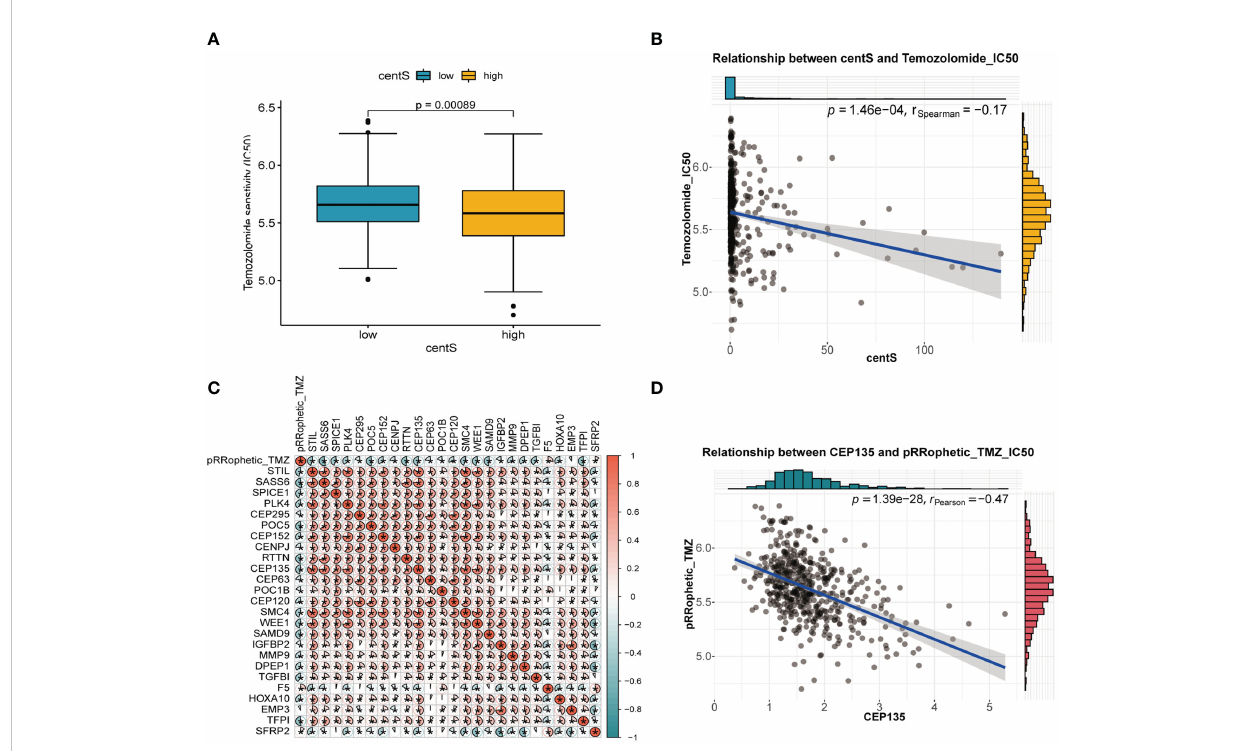
FIGURE 10 Temozolomide sensitivity analysis of centS and CRGs in LGG. (A) difference analysis of IC50 value of Temozolomide in high- and low- centS group performed by “ pRRophetic ” package. (B) Correlation analysis of centS and IC50 value of Temozolomide. (C) The correlation matrix to show the relationship of the IC50 value of Temozolomide with 13 CRGs and 12 signature genes. Blue indicates that the gene is negatively correlated with the IC50 of Temozolomide, and red indicates that the gene is positively correlated with the IC50 of Temozolomide. (D) Correlation analysis of key gene CEP135 and IC50 value of Temozolomide. *p <